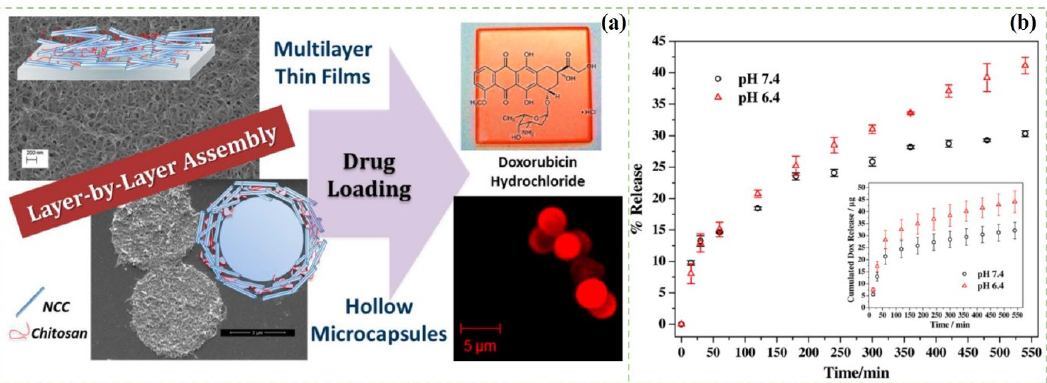
Figure 3. ( a ) Schematic illustration of the preparation of the nanocrystalline/chitosan; ( b ) Release profile of doxorubicin hydrochloride from the composite film at 37 °C using PBS buffer as release profile of doxorubicin hydrochloride from the composite film at 37 ◦ C using PBS buffer as release media [83]. media